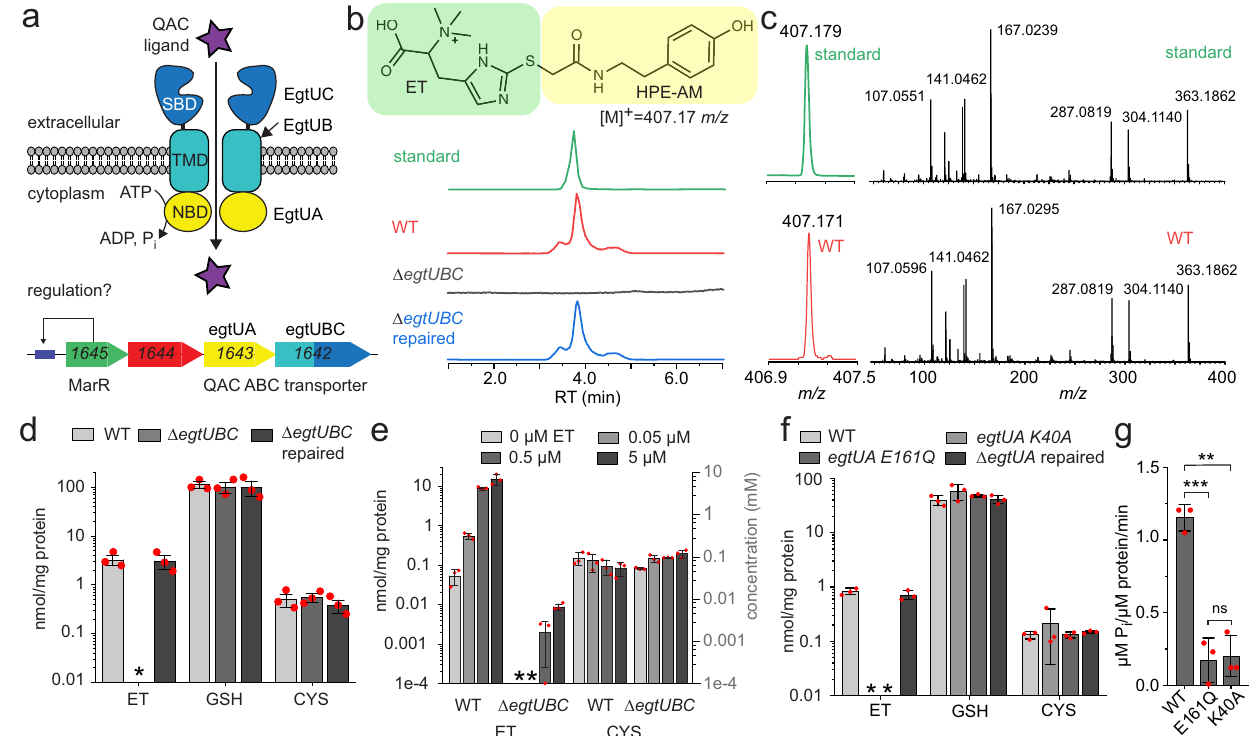
Fig. 1 | spd_1643-1642 encodes an ET uptake transporter in S. pneumoniae denoted EgtU. a Hypothesized functional roles of the genes of the streptococcal conserved operon 30 harboring a candidate QAC ABC transporter, encoded by spd_1642-1643 . b Structure of HPE-IAM-derivatized (capped) ET and LC traces of capped ET from authentic ET (standard) and cell lysates from the indicated S. pneumoniae D39 strains grown on BHI media. WT, wild-type; Δ egtU , markerless deletion of most of the egtU gene, which was then repaired via insertion of a wild-type egtU allele ( Δ egtU repaired). c MS1 ( left ) and LC-MS/MS ( right ) spectra of HPE-IAM capped ET found in a wild-type (WT) cell lysate from cells grown in BHI vs. authentic ET (standard). d Normalized content of ET, GSH and CYS found in the indicated strains of S. pneumoniae D39 grown in BHI in biological